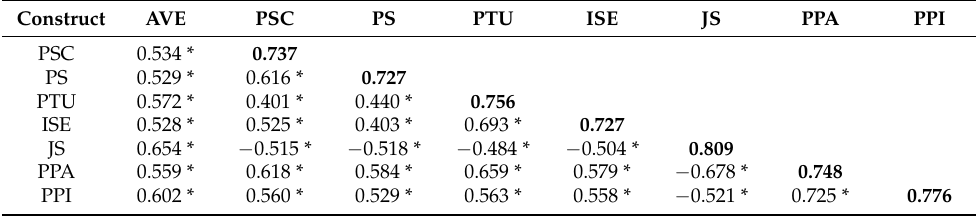
Table 3. Discriminant